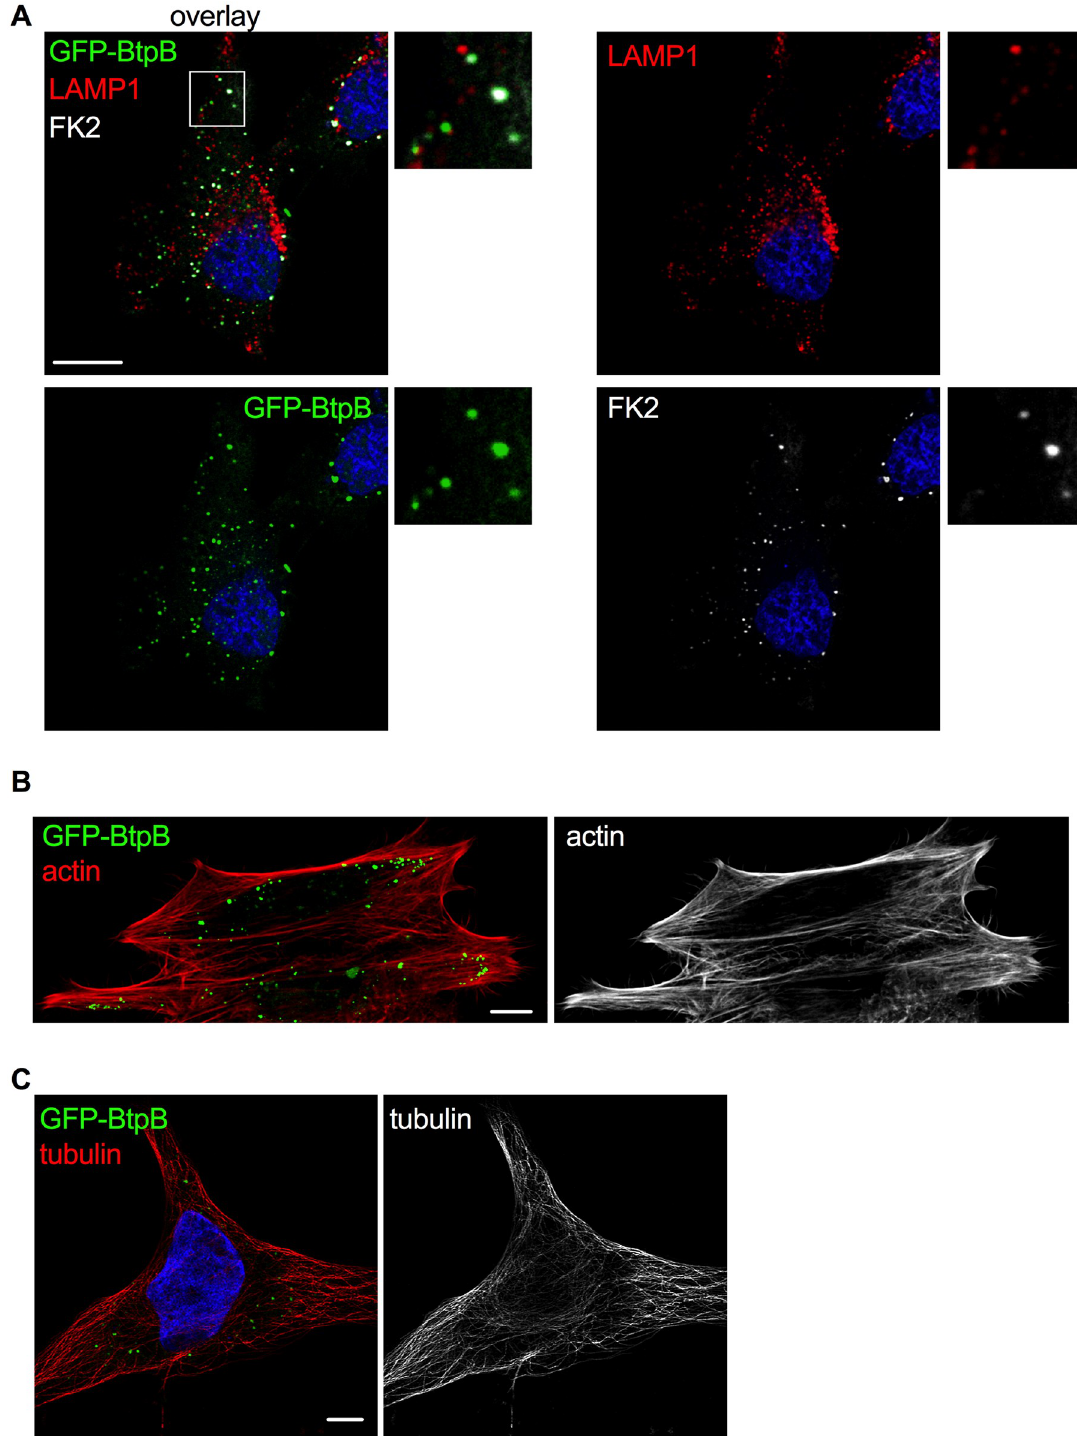
Fig 5. Localization of ectopically expressed BtpB in human cells. HeLa cells expressing GFP-BtpB (green) were labelled and analyzed by confocal immunofluorescence microscopy. Representative images are shown. (A) Cells were labelled with FK2 (cyan) along with LAMP1 (red) antibodies. The nuclei are labelled with DAPI (blue). (B) Cells were labelled with phalloidin for visualization of the actin cytoskeleton (red) and (C) with anti-tubulin antibody for visualization of the microtubules (red). Scale bars correspond to 5 μ m. The tubulin image was obtained with Airyscan confocal imaging